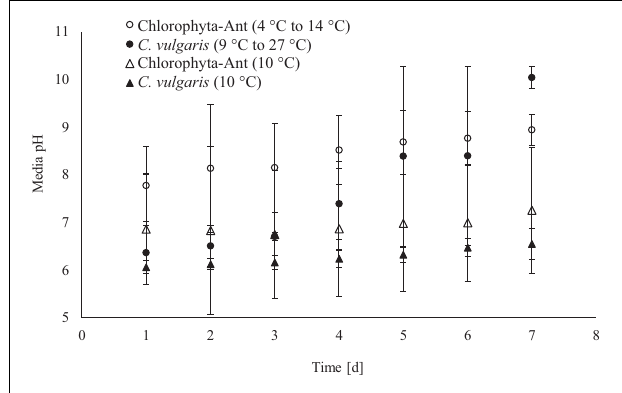
FIGURE 5 | Real-time media pH measurements averaged across 24 h for qualitative insight of culture growth.